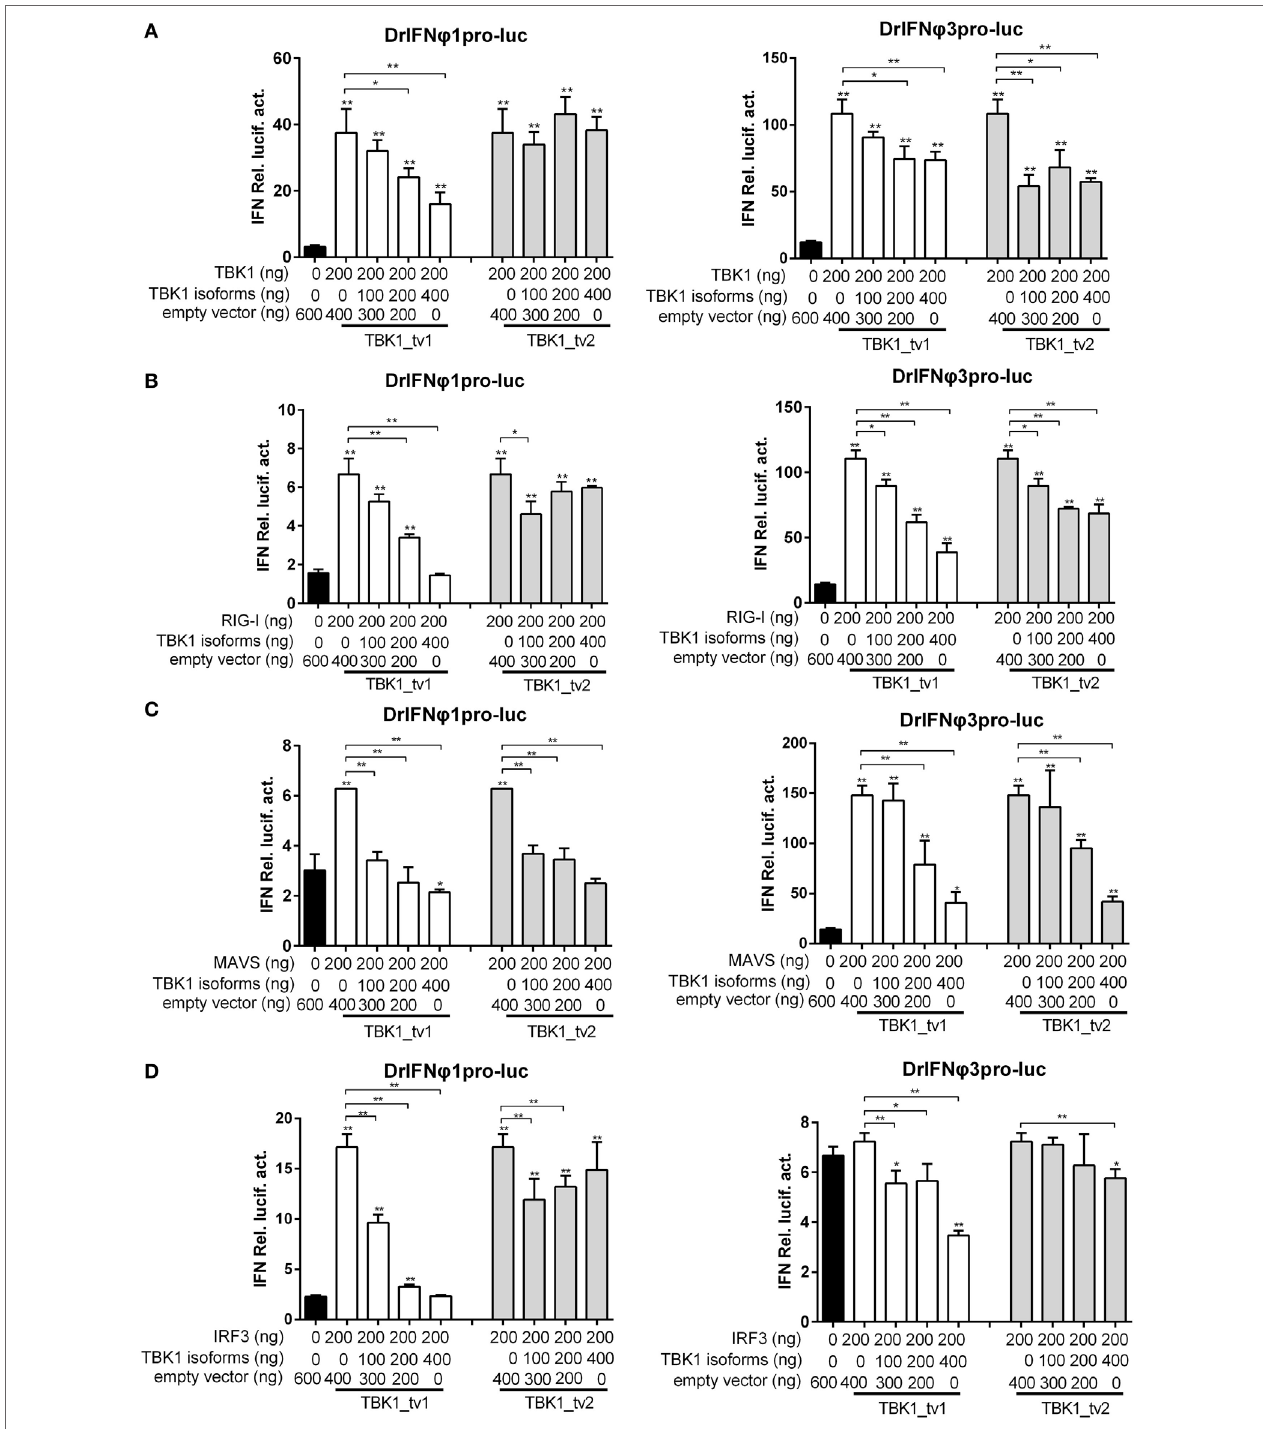
FigUre 3 | TANK-binding kinase 1 (TBK1) isoforms negatively regulate type I interferon (IFN) signaling mediated by TBK1 (a) , retinoic acid-inducible gene I (RIG-I) (B) , mitochondria antiviral-signaling protein (MAVS) (c) , and IRF3 (D) . Epithelioma papulosum cyprini (EPC) cells seeded overnight in 24-well plates at 3 × 10 5 cells per well were transiently transfected with various indicated plasmids with indicated DNA concentration, together with 25 ng Renilla and 250 ng IFN φ 1 or IFN φ 3 reporter plasmids. Thirty hours post-transfection, the cells were infected with spring viremia of carp virus (SVCV) at a multiplicity of infection of 1. Another 16 h later, the cells were harvested for the detection of luciferase activity. Data represent mean ± SEM ( n = 3) and were tested for statistical significance using a one-way ANOVA followed by a Tukey test. * p < 0.05, ** p < 0.01. The asterisk above the error bars indicated statistical significance using the group transfected with empty plasmid with SVCV infection as the control group. The asterisk above the bracket indicated statistical significance between the two groups connected by the